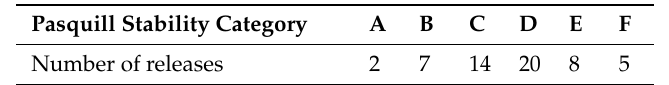
Figure 6. The layout and dimensions of the sampler array used in the Prairie Grass experiment. From Herring, S. and Huq, P., 2016, 17th International Conference on Harmonisation within Atmospheric Dispersion Modelling for Regulatory Purposes [7]. Table 5. Summary of Pasquill stability categories associated with usable data from the Prairie Grass releases.